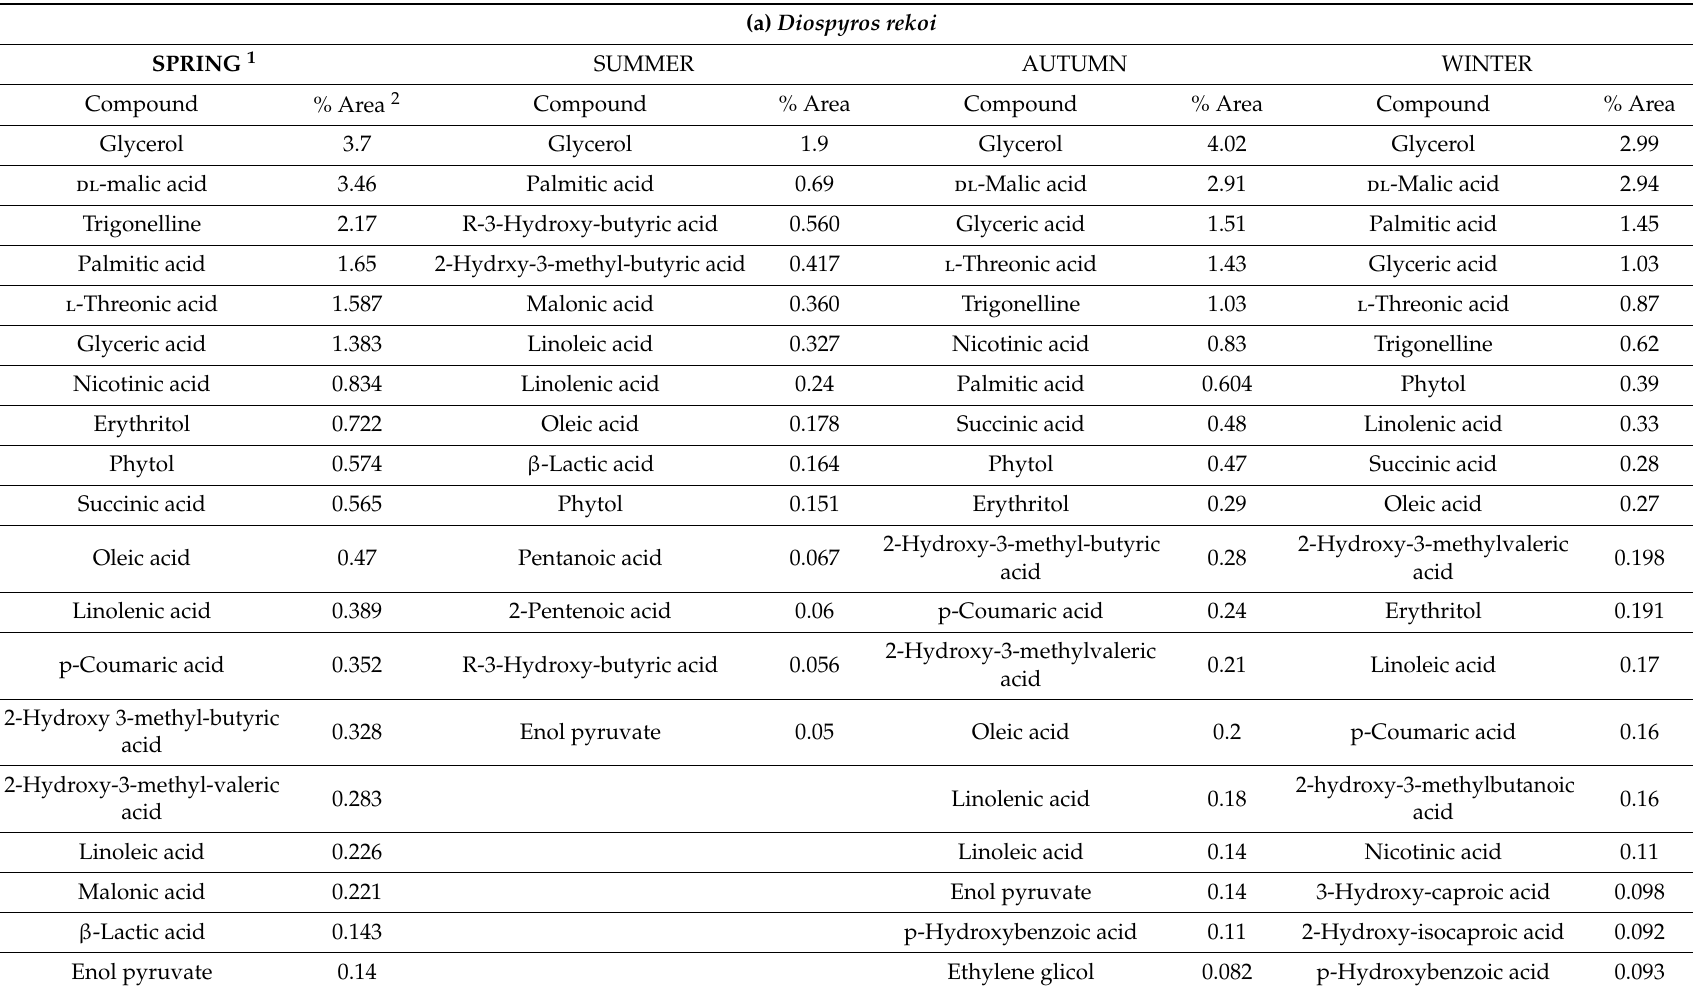
Table 2. Metabolites identified by a targeted metabolomic GC-MS analysis of Diospyros leaf extracts. Metabolites detected in leaf extracts of D. rekoi and D. digyna trees sampled in each season of 2014. Each extract was prepared with leaves of 5 individual trees per sampling site per